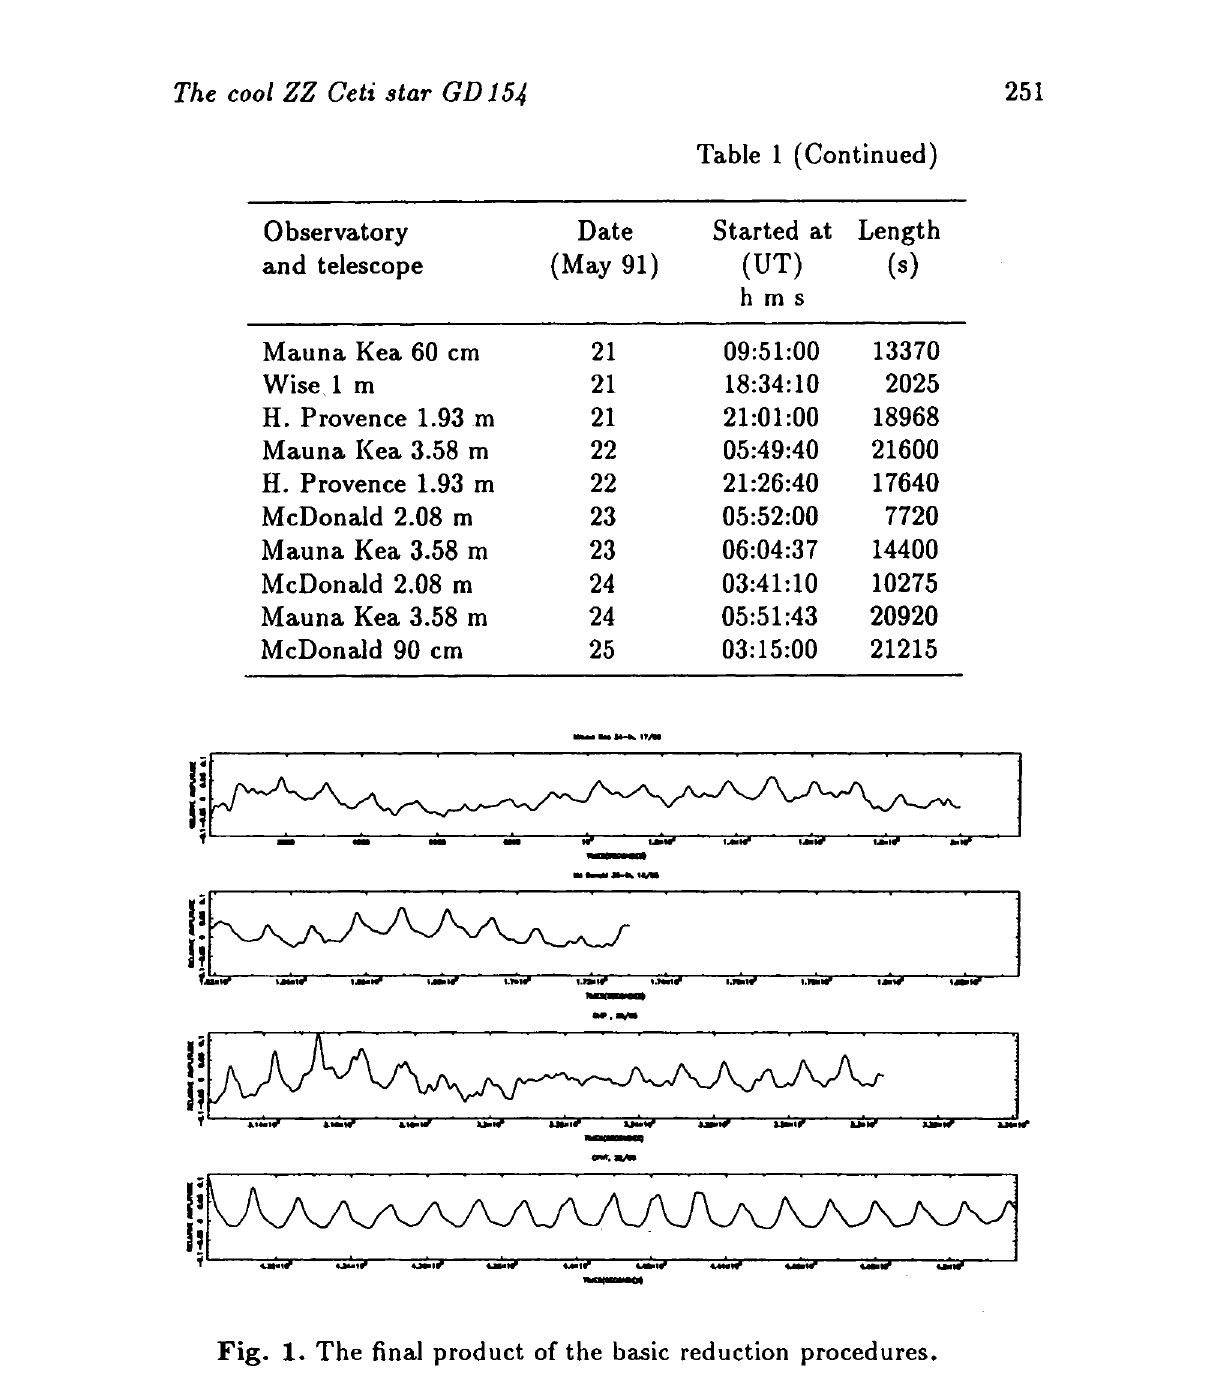
Fig. 1. The final product of the basic reduction procedures. ferent methods, one of them running in the time domain (ISWF, Pon- man 1981), and the second one running in the dual domain (based on the CLEAN method, Hogbom, 1974). In each case, all the peaks